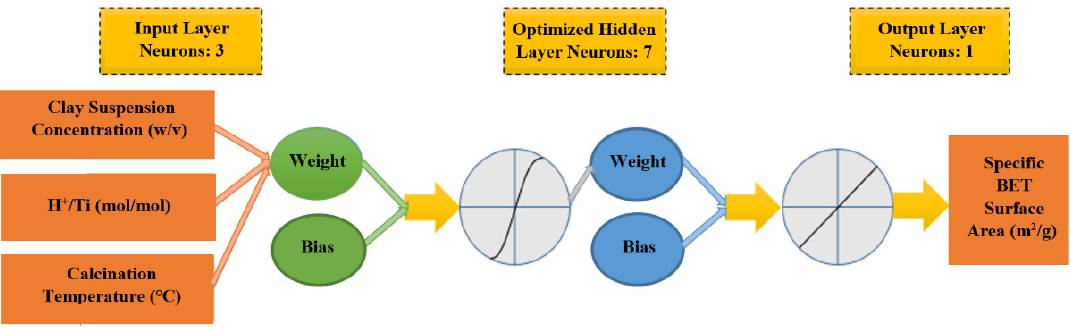
Figure 2. The structure of ANN model designed in the present work.